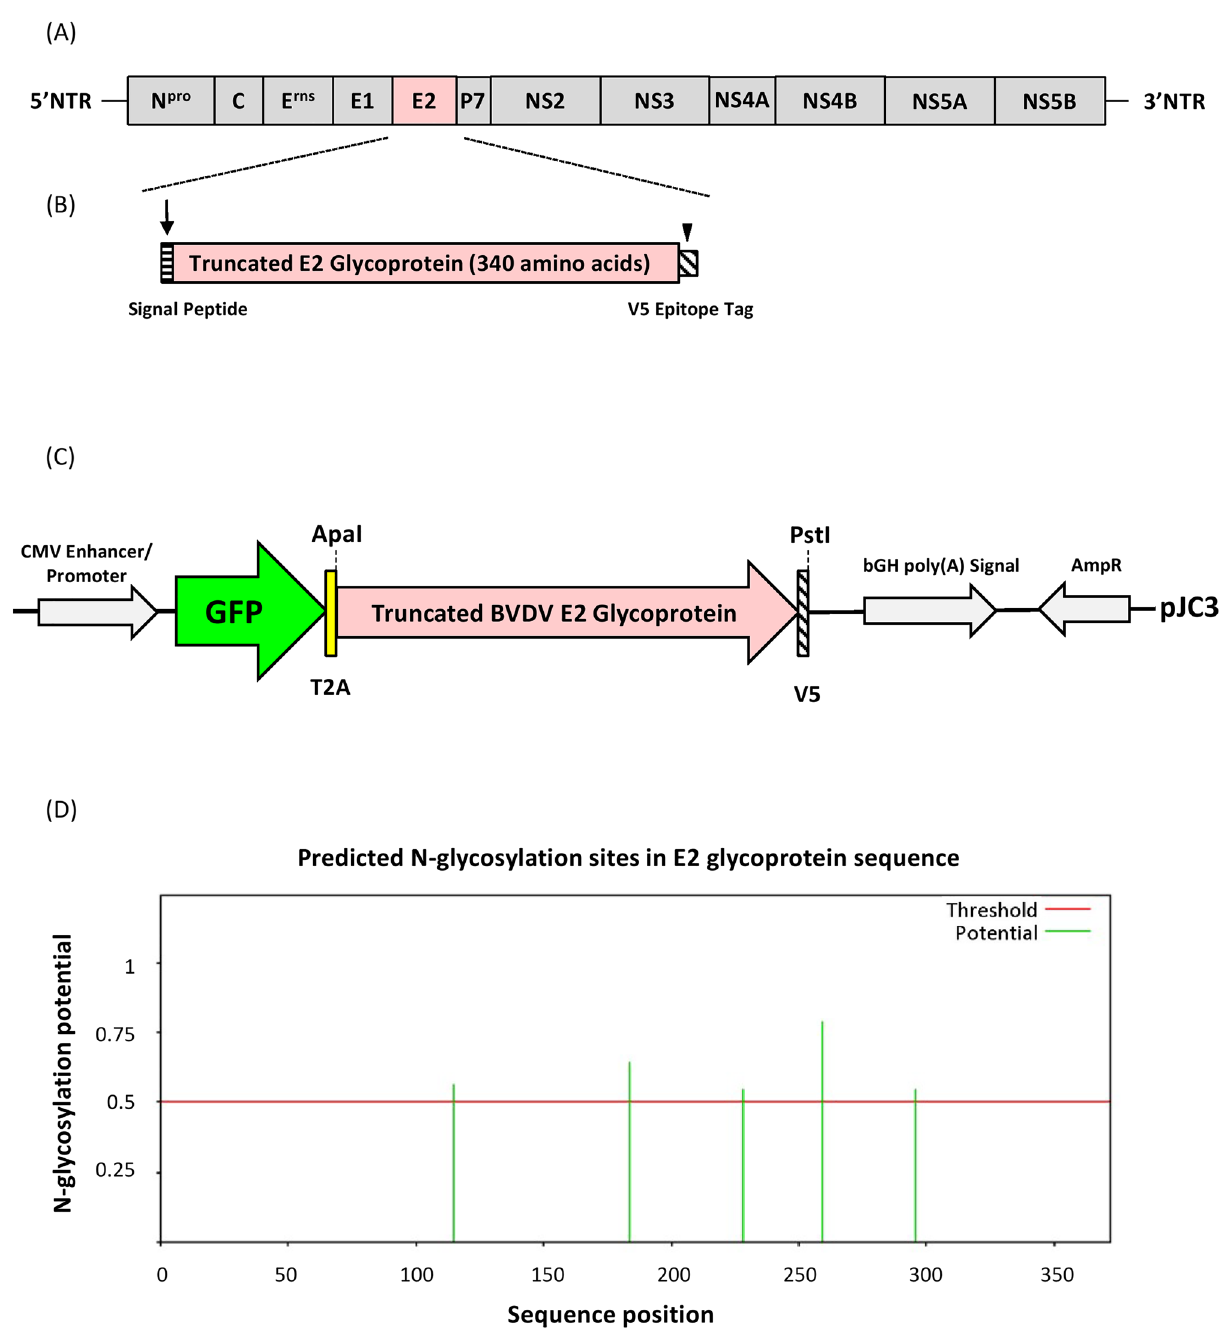
Figure 1. Genome structure of BVDV and synthesis of the region encoding the E2 glycoprotein. BVDV genome organization (not to scale) and polyprotein processing ( A ). Cloning strategy and synthesis of genes encoding the C-terminally truncated (transmembrane anchoring domains deleted) forms of the E2 glycoprotein (boxed areas) are shown, together with the signal peptide (horizontal hatching area) and the C-terminal V5 epitope tag (slash area) ( B ). Cloning of truncated form of E2 glycoprotein into pJC3 expression vector. Plasmid pJC3 encodes a [GFP-T2A-mCherry] polyprotein encoded by a single open reading frame. Transcription is driven by the human cytomegalovirus enhancer/promoter and the mRNA polyadenylated by the bovine growth hormone polyadenylation signal. Sequences encoding the truncated form of E2 glycoprotein were excised by restriction with ApaI and PstI from the pGEM-T Easy Vector, then inserted to pJC3, similarly restricted, to remove mCherry FP and create plasmid [GFP-T2A-BVDV-E2 trunk] ( C ). The NetNGlyc-1.0 server (https:// servi ces. healt htech. dtu. dk/ servi ce. php? NetNG lyc-1.0) was used to predict N-glycosylated sites from full-length E2 glycoproteins. An N-glycosylation potential of > 0.5 was the cut-off value for sequences ( D